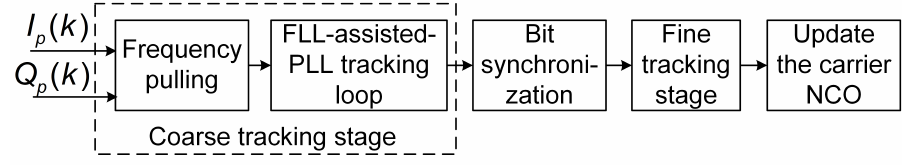
Figure 1. Block diagram of the conventional two-stage carrier tracking control